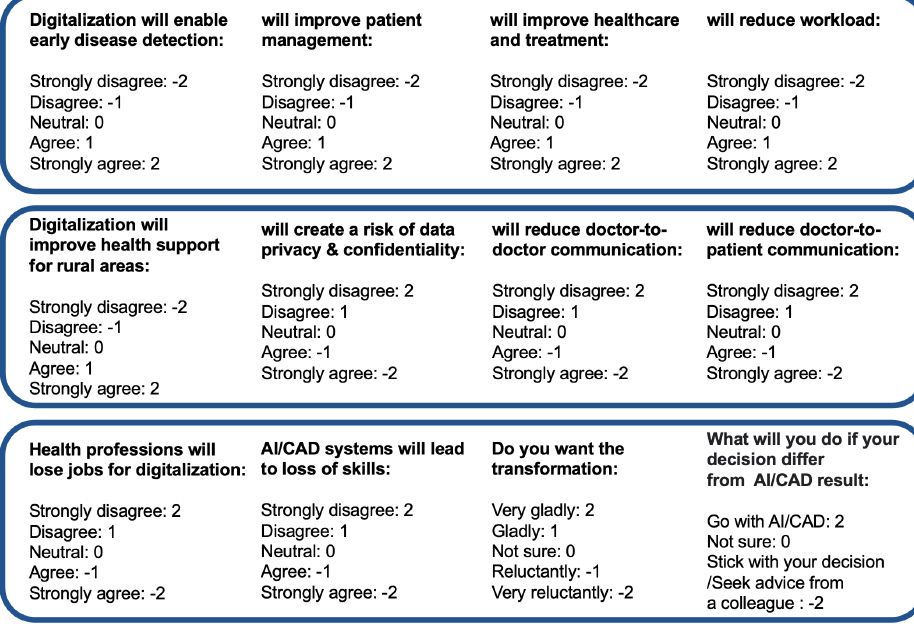
Figure 14. Confidence score